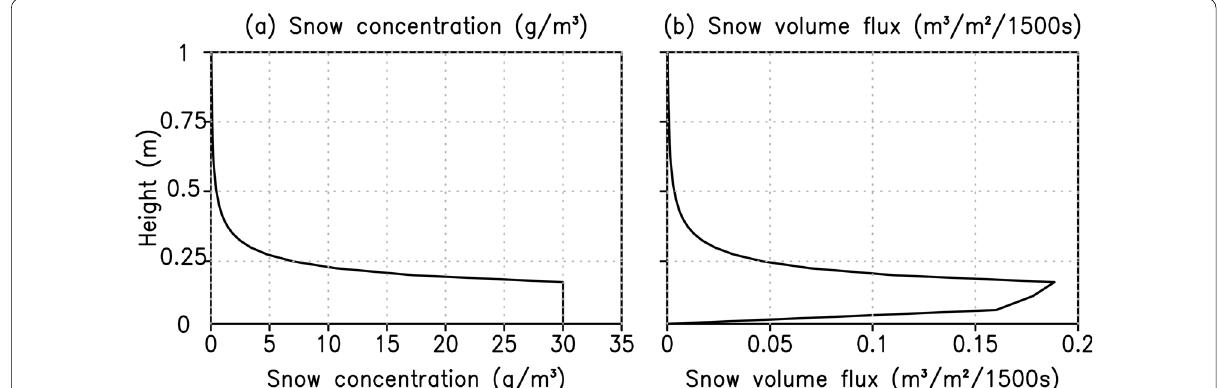
Fig. 3 Vertical profiles of a snow concentration and b snow volume flux of the initial condition on the western boundary plane of the snow particle module